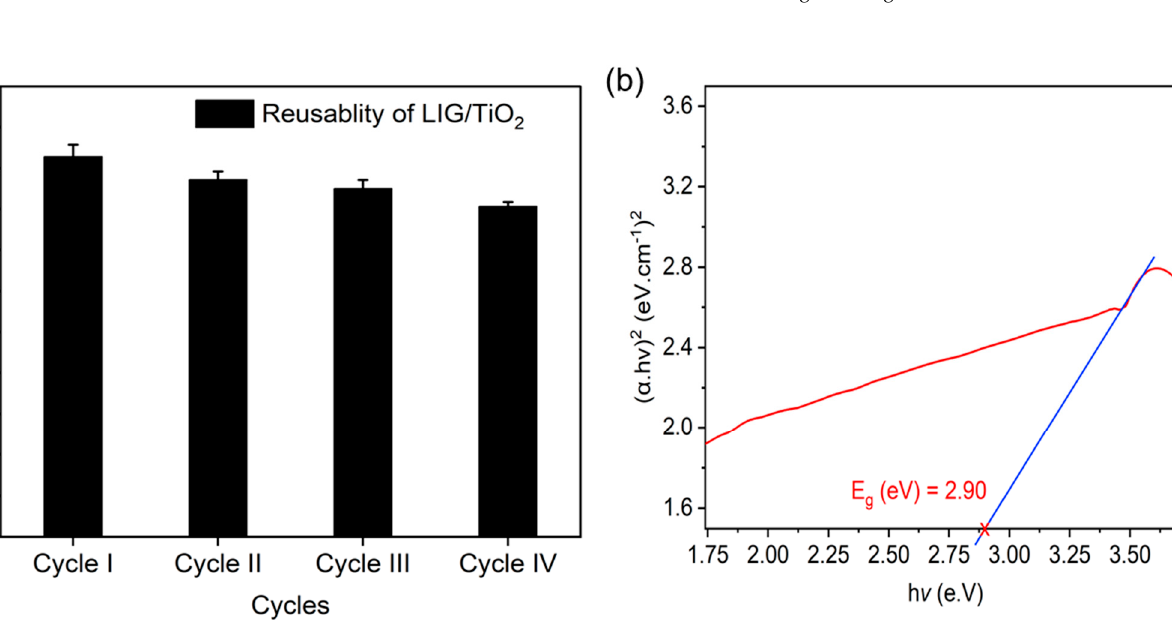
Table 4. Comparison of overall MO removal efficiency of different